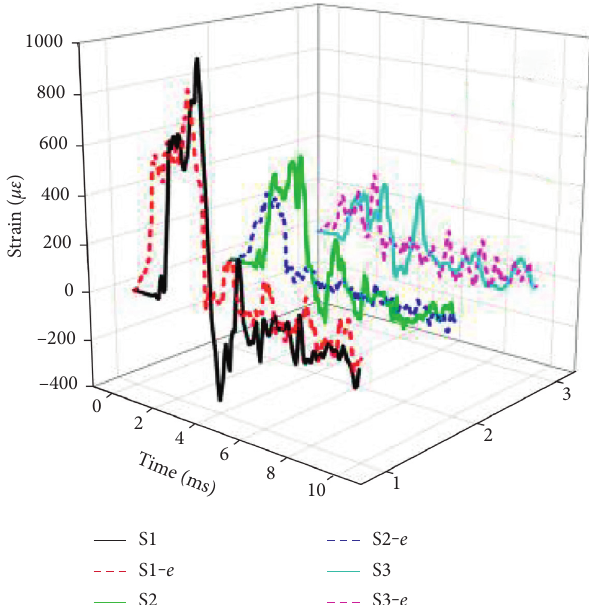
Figure 6: 80%/90% foam aluminum strain diagram.